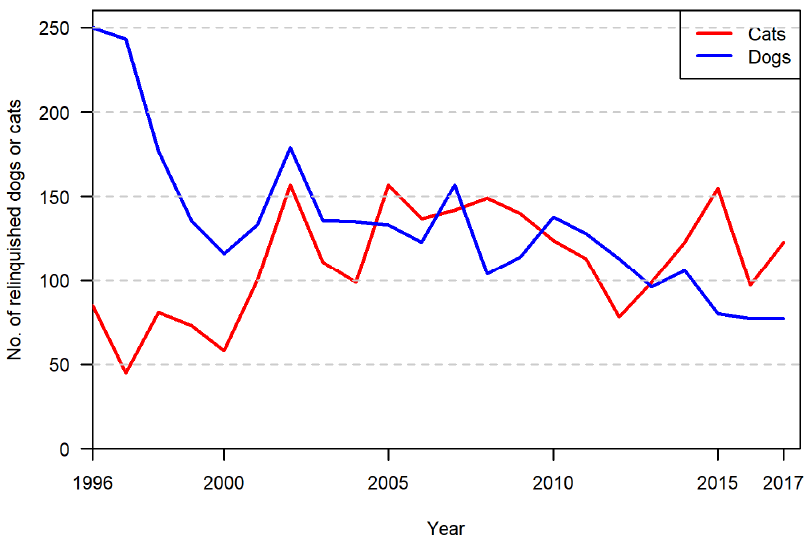
Figure 1. Annual number of owner-relinquished dogs and cats at a large Danish shelter from 1996 to 2017.